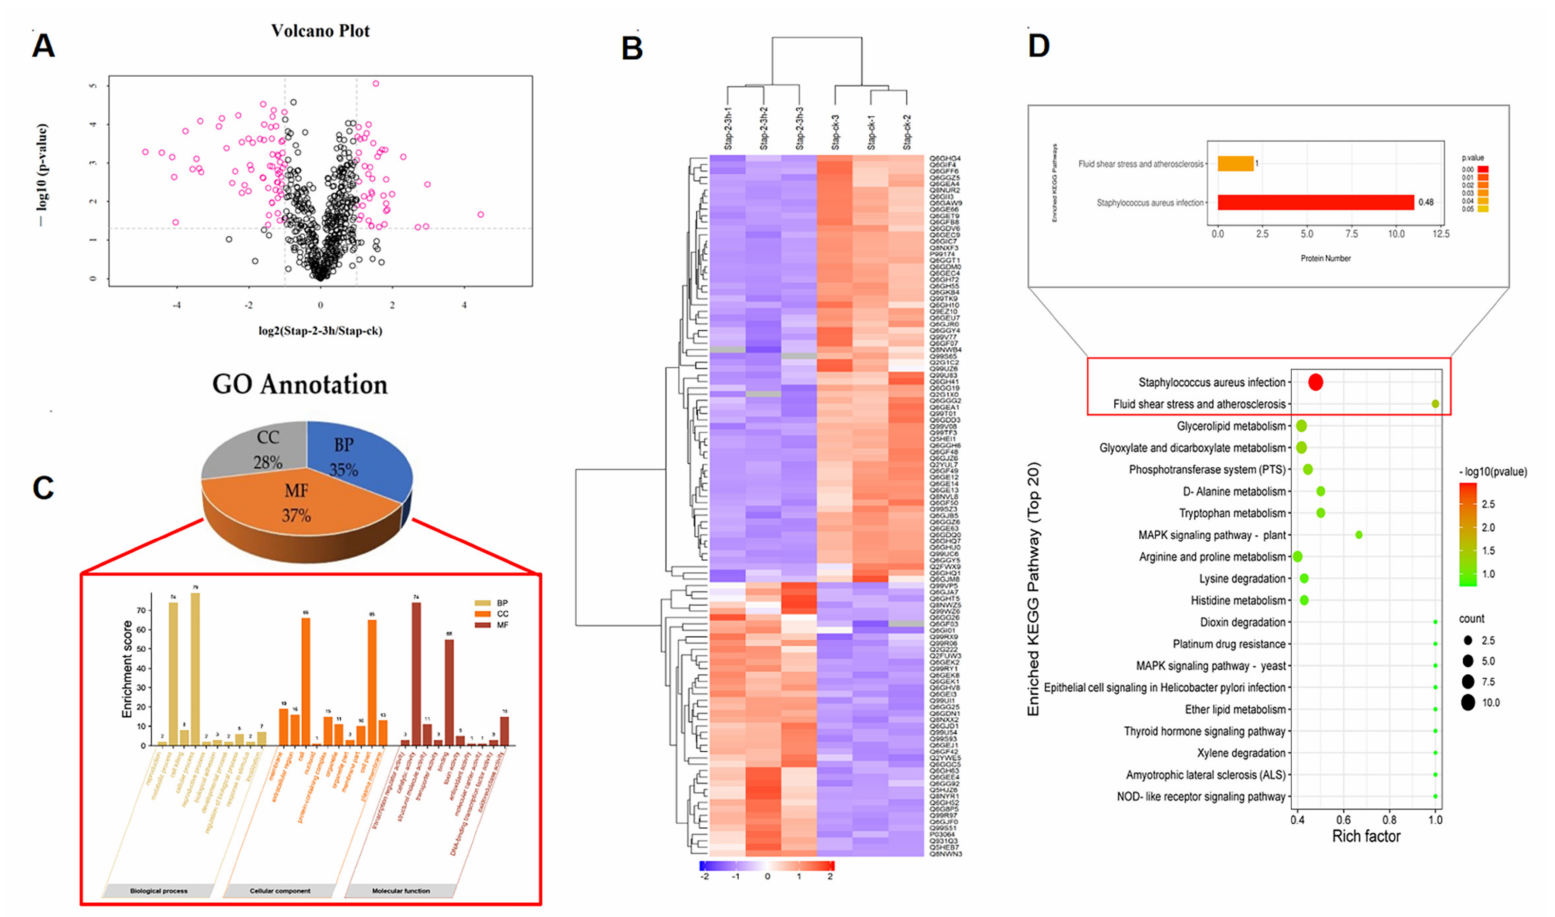
Figure 3. Proteomics results of S.aureus treated with actinomycin D. ( A ) Volcano plot of DEPs, Stap-2–3 h represents the treatment group, Stap-ck represents the control group, and DEPs (Regulated > 2.0-fold; p < 0.05) are represented by the pink color. ( B ) Hierarchical cluster analysis of all the DEPs. ( C ) Gene ontology annotation of differentially expressed proteins. BP represents the biological processes, MF represents molecular function and CC represents the cellular components of proteins; the top 10 enrichments of BP, CC, and MF are shown. ( D ) Top 20 KEGG pathways of the identified DEPs. Color represents p -value; the red color represents low p -value, the green color represents high p -value; the pathways with a red color represent those that are altered and the circle size represents gene